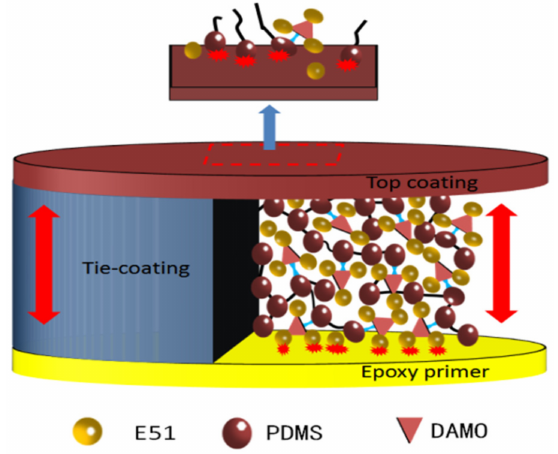
Figure 11. Schematic diagram of tie mechanism of the modified silicone tie-coating.